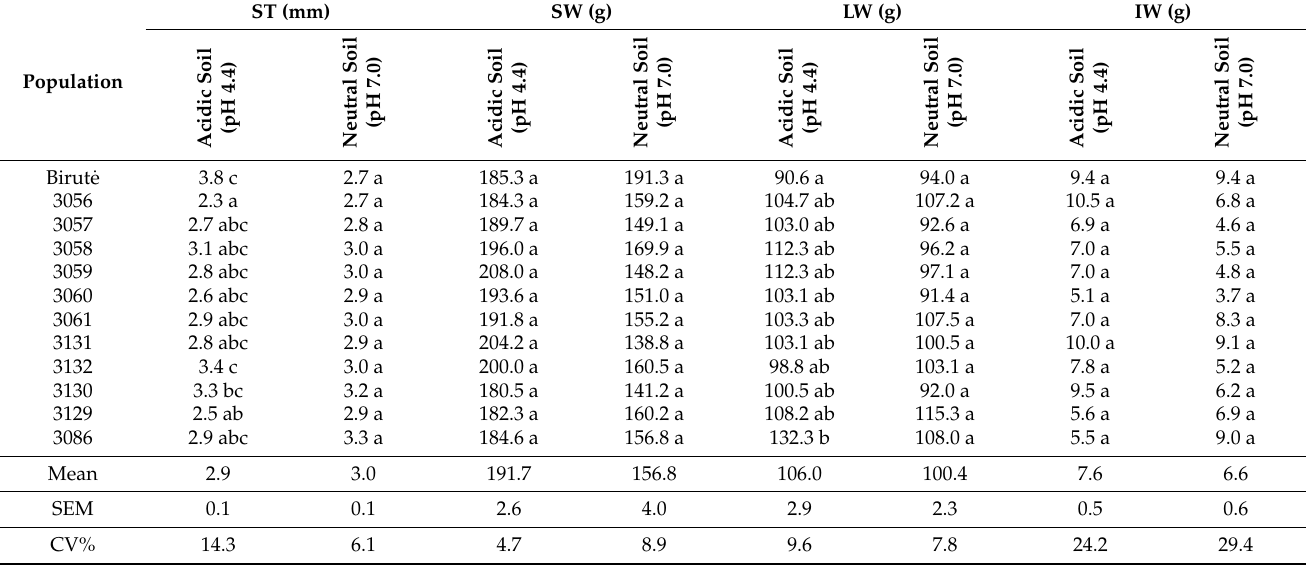
Table 6. The mean values of stem thickness, stem weight, leaf weight, and inflorescence weight under different experimental sites (I and